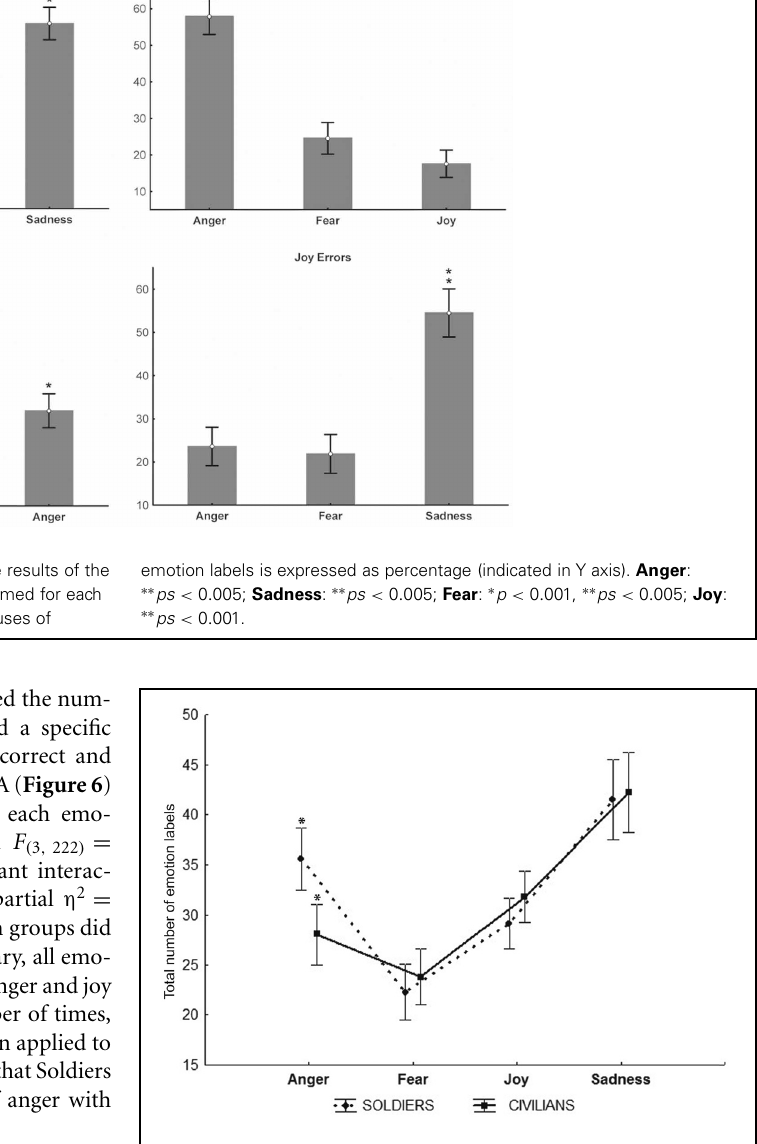
FIGURE 6 | Plots show the results of the Response strategy analysis that is the number of times that both groups of participants used